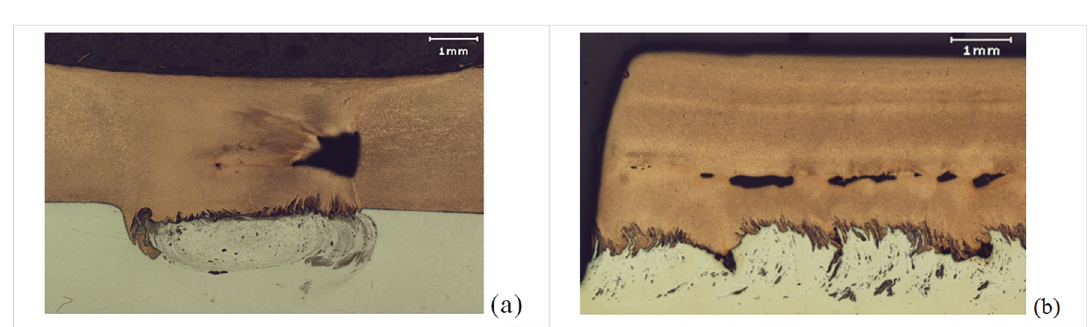
Figure 10. Micrograph showing the worm hole defect: (a) transversal section (WD 900/10) and (b) longitudinal section (800/10).